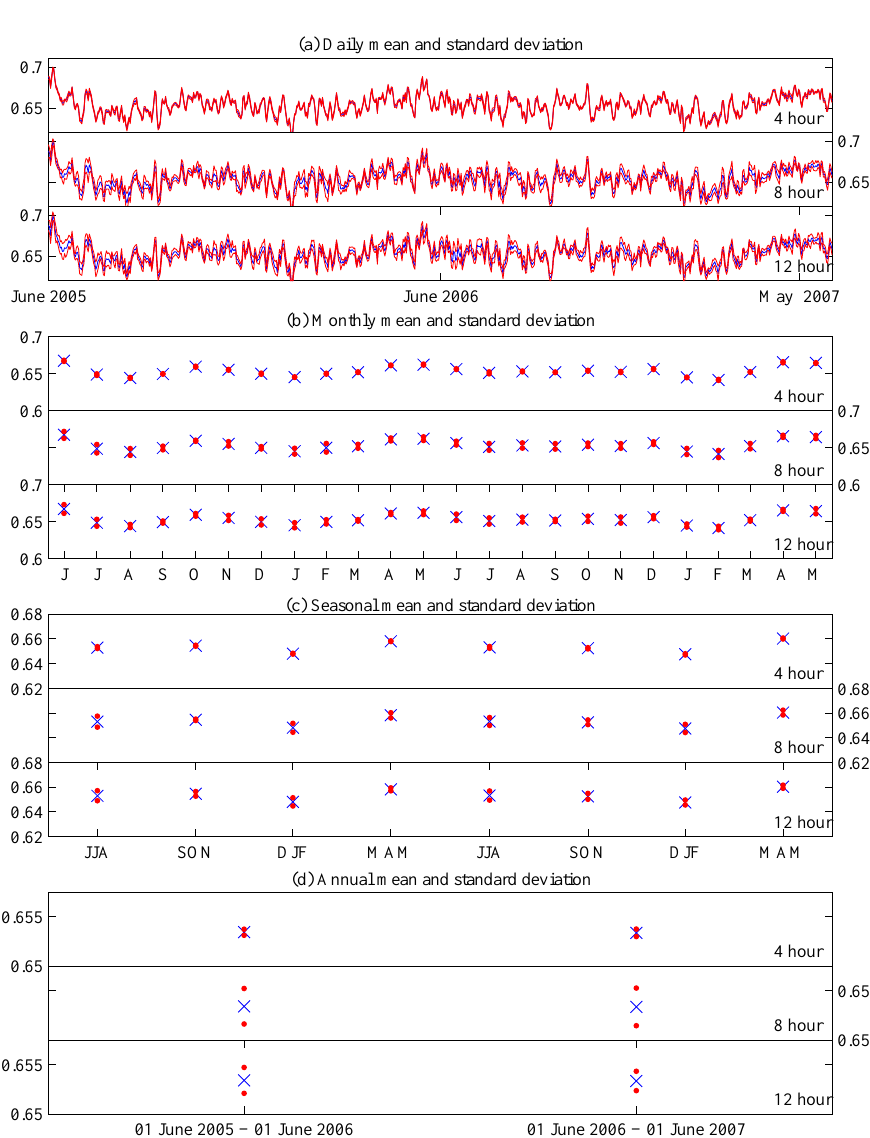
Figure 5. All panels ( a – d ) as for Figure 3 but for the sunlit